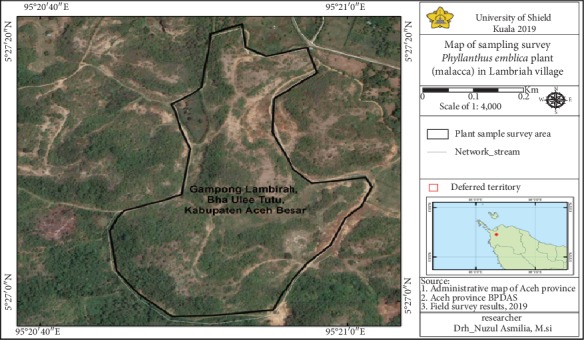
Sampling location.